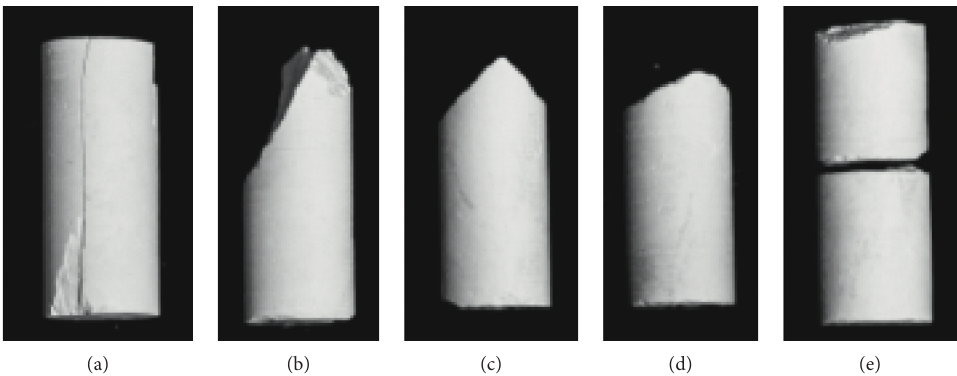
Figure 4: Photographs of failed specimens of Mons chalk. A transition of failure patterns with increase in radial stress. Specimen (a) shows axial splitting observed in uniaxial compression test, σ 3 � 0; specimen (b) exhibits a shear band with angle of 67 ° from σ 3 � 1.5MPa; specimen (c) also illustrates a shear band with angle of 55 ° from σ 3 � 2.5MPa; specimen (d) shows a transitional failure plane with angle of 36 ° from σ 3 � 5MPa; and stage (e) clearly shows a compaction band under σ 3 � 10MPa